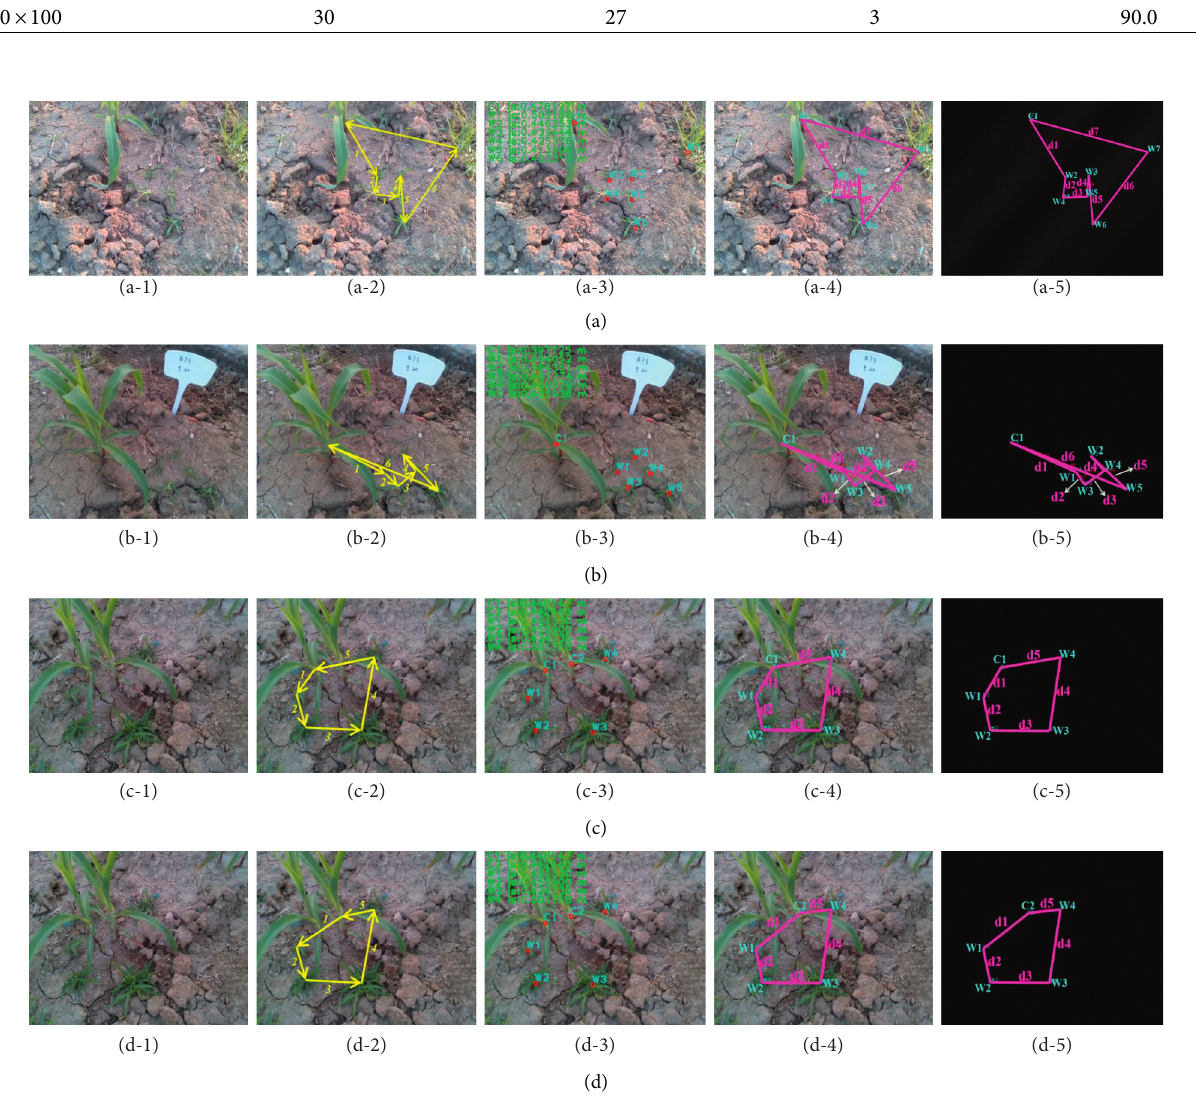
Figure 11: Multitarget depth ranging and shortest path planning in different